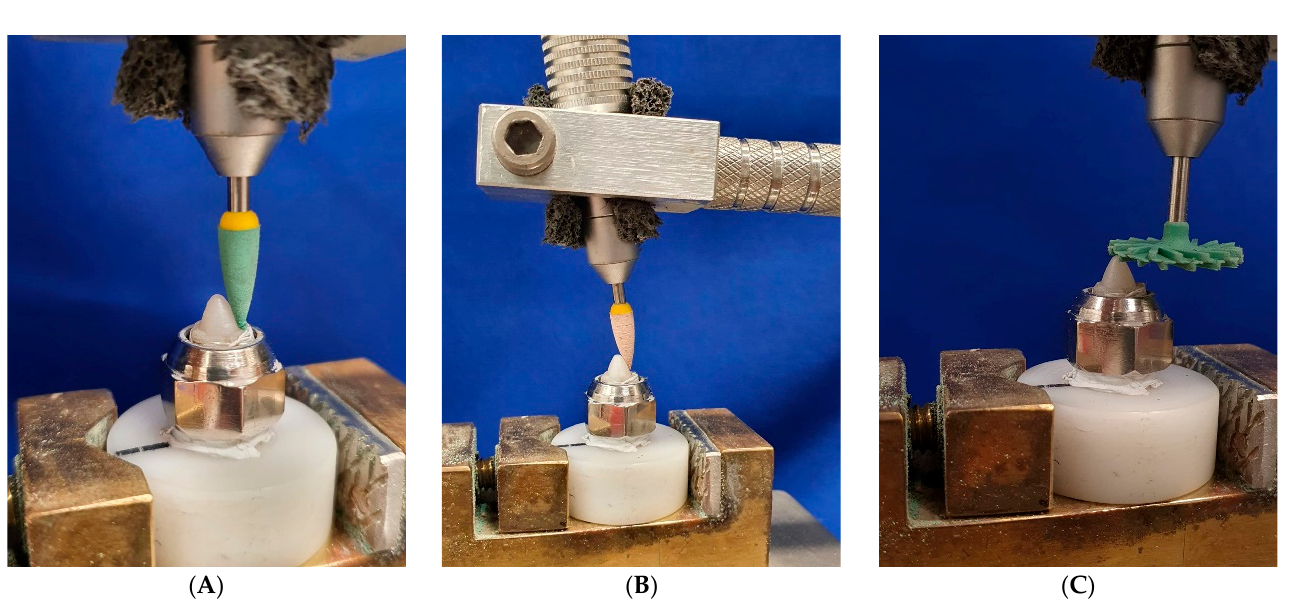
Figure 2. ( A ) Staining; ( B ) glazing.